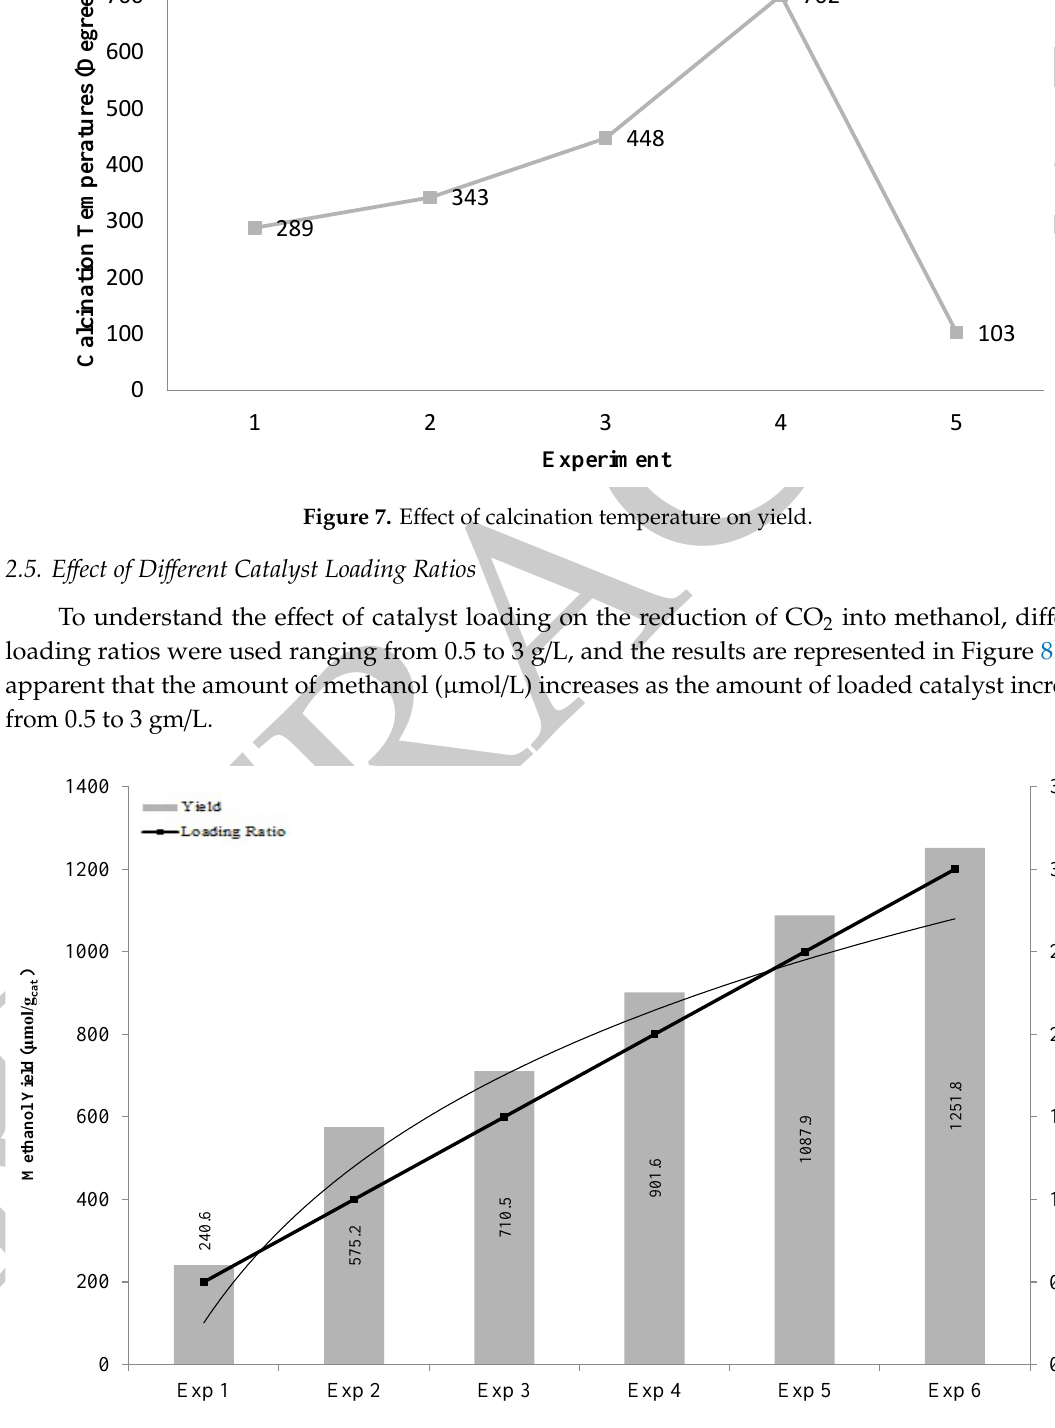
Figure 8. Effect of different catalyst loading ratios on the yield of methanol. Figure 8. E ff ect of di ff erent catalyst loading ratios on the yield of